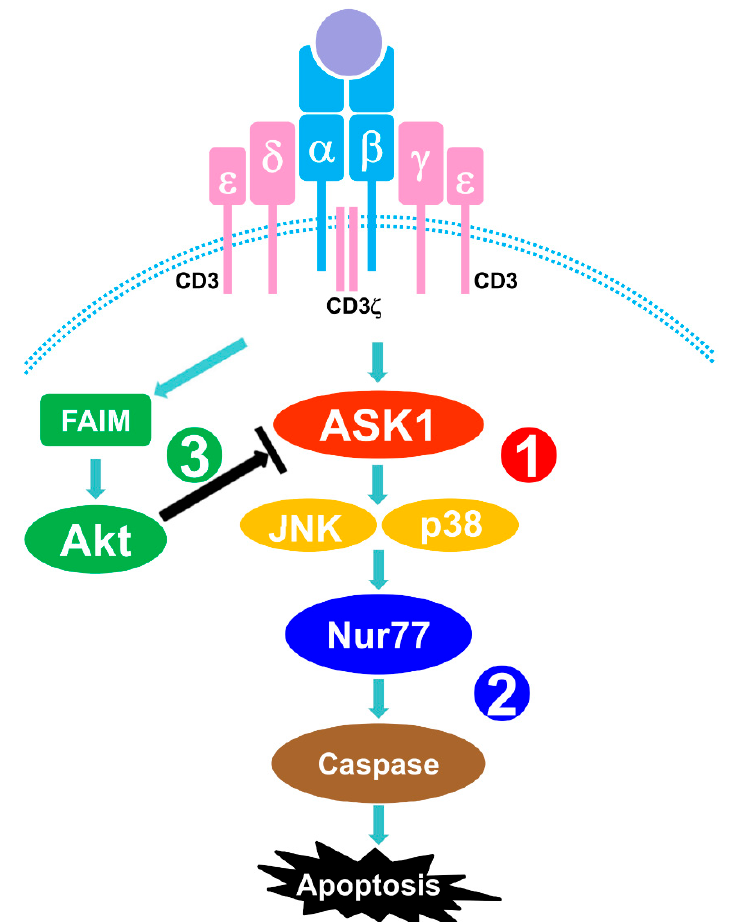
Figure 5. Schematic representation of ASK1-JNK / p38-Nur77 signaling cascades in TCR-stimulated thymocytes. (1) Upon engagement of TCR, ASK1 is phosphorylated and further activates JNK and p38 MAP kinases. (2) Nur77 expression is upregulated by TCR-ASK1-JNK / p38 signaling and is required for caspase activation, leading to the apoptosis of thymocytes. (3) Akt is activated upon TCR stimulation